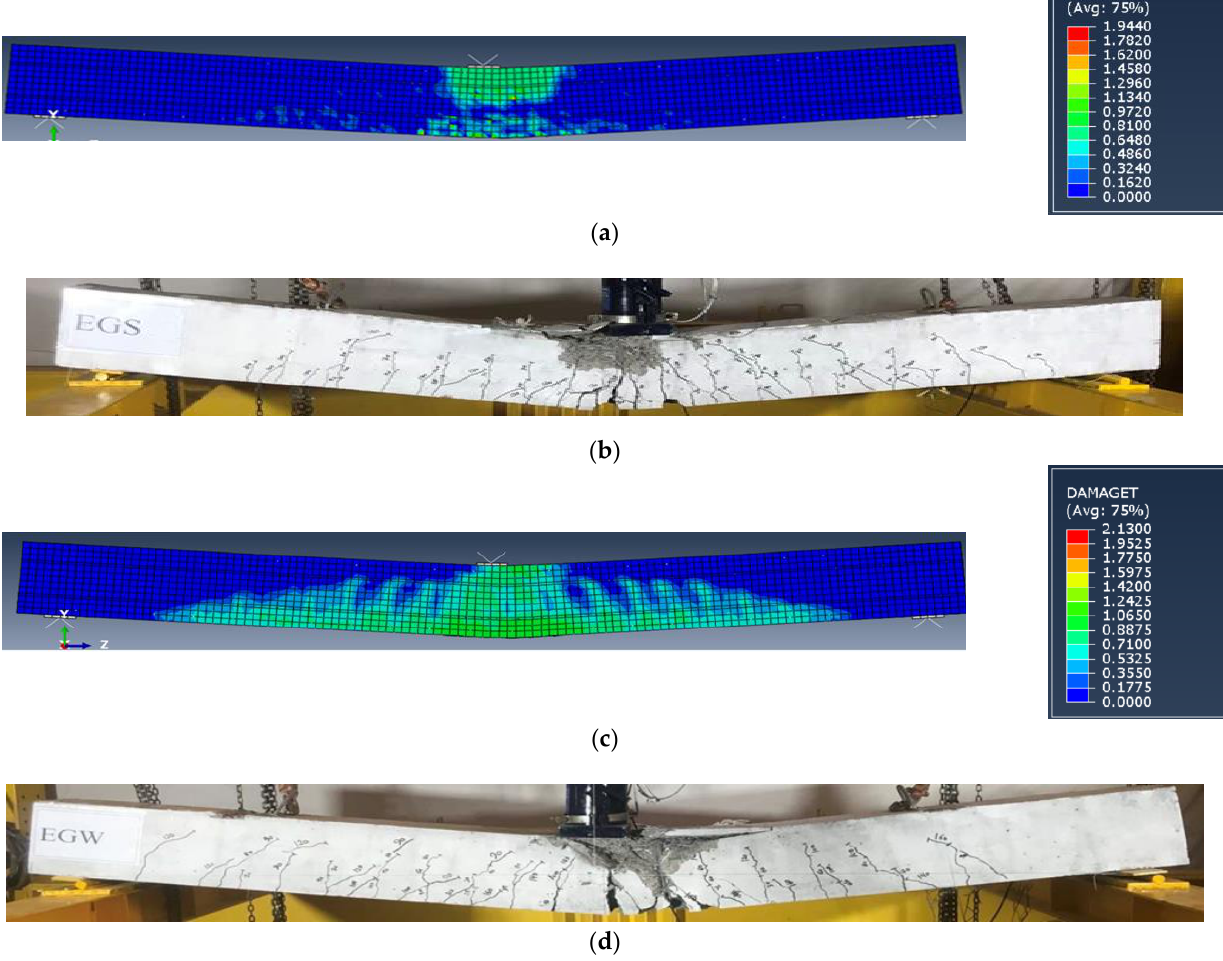
Figure 15. Cracking pattern comparisons. ( a ) FE crack pattern for specimen EGS. ( b ) Experimental crack pattern for specimen EGS. ( c ) FE crack pattern for specimen EGW. ( d ) Experimental crack pattern for specimen EGW.